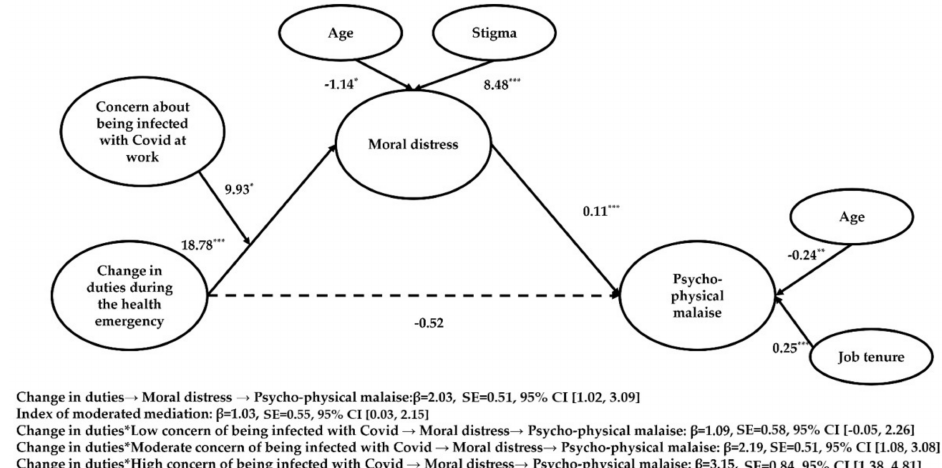
Figure 2. Path coefficients for the moderated mediation